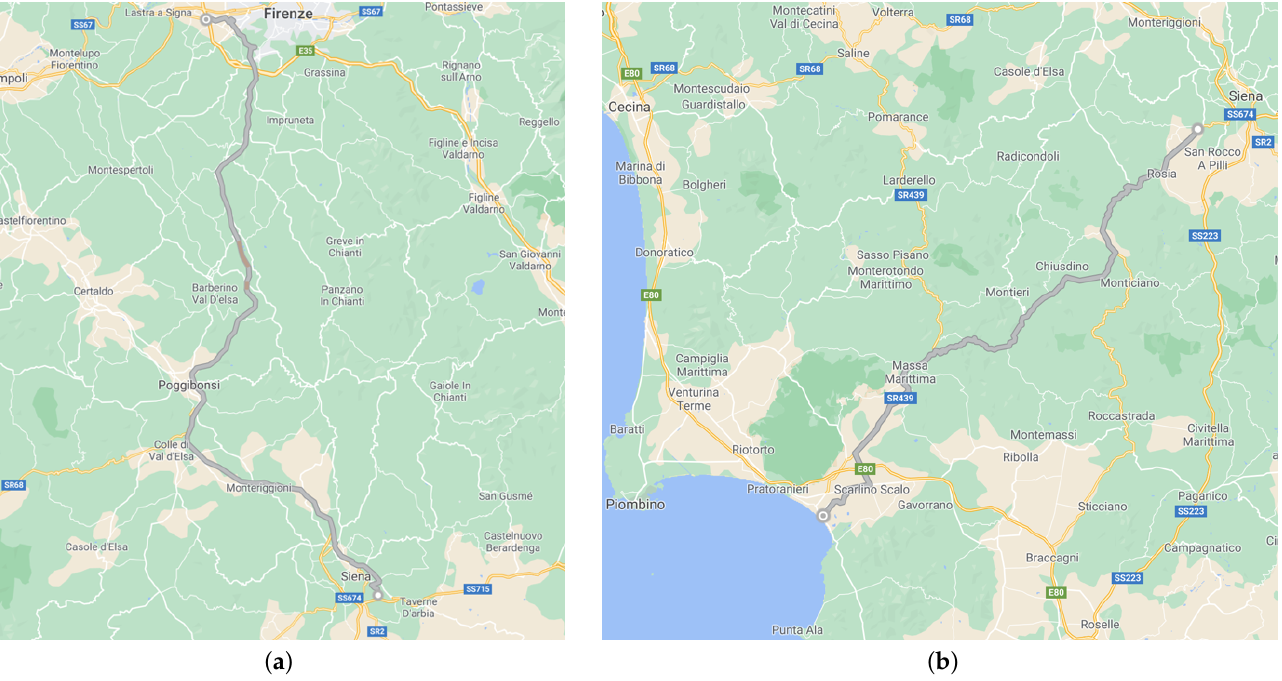
Figure 6. Exploited itineraries for tracking tests: ( a ) itinerary including dirt roads, urban streets and freeways; ( b ) itinerary including urban streets, suburban streets and wooden